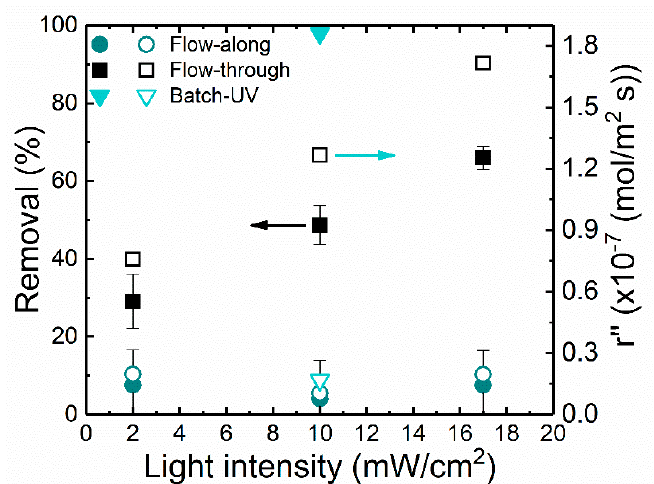
Figure 6. MB removal (filled) and photocatalytic membrane reaction rate (hollow) at different light intensities operated in the batch, flow-along and flow-through processes: flow rate 1 mL/min, MB concentration 1 mg/L, 22 °C, in flow-along and flow-through pH 8.6, 1 mM NaHCO 3 , 10 mM NaCl.